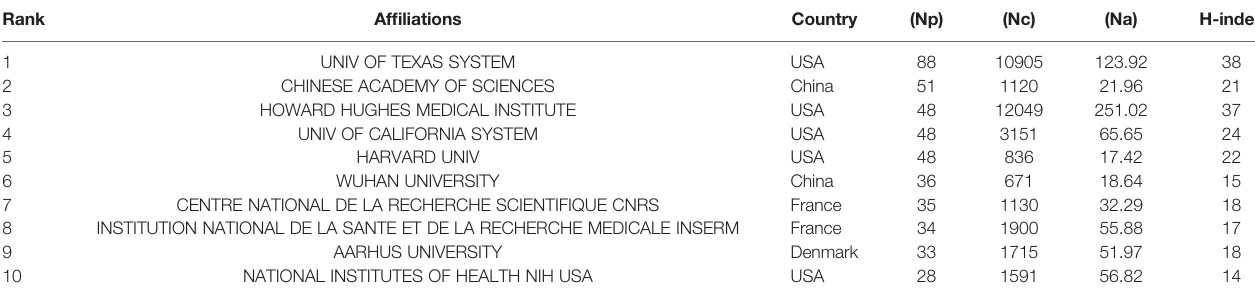
TABLE 2 | The top 10 productive af fi